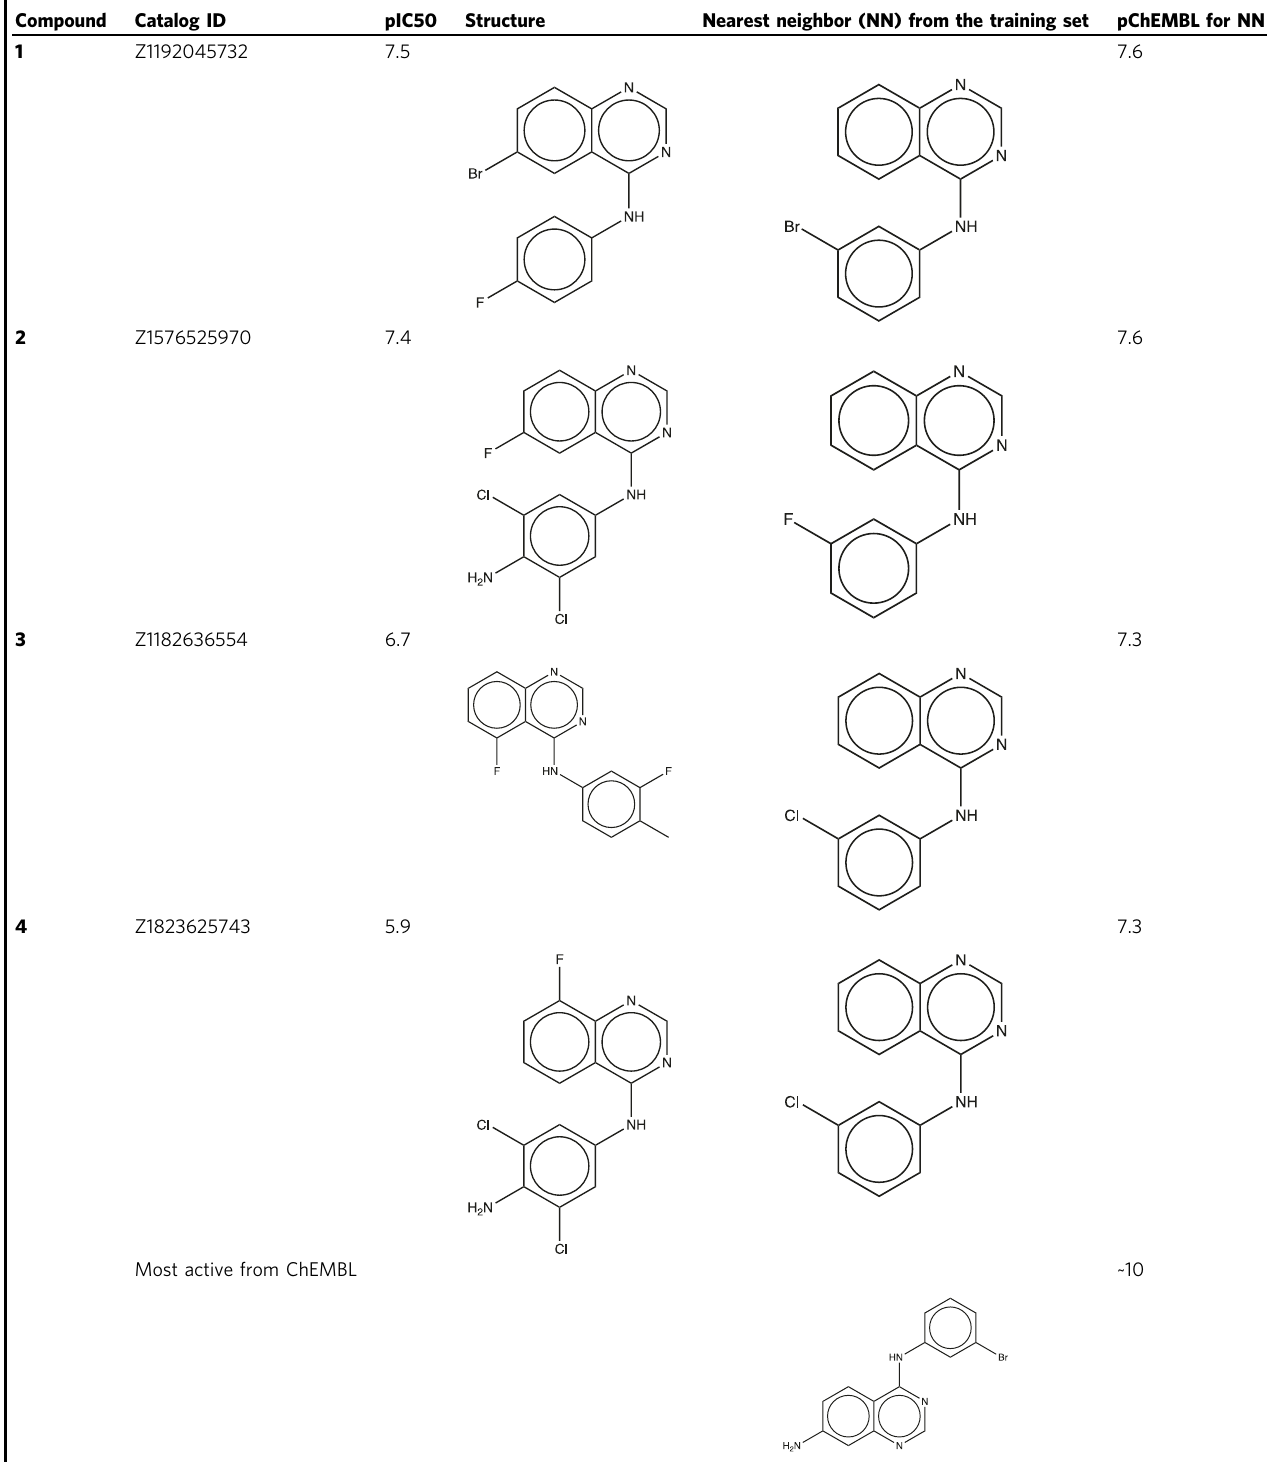
Table 1 Data for EGFR kinase inhibiton of compounds 1 –